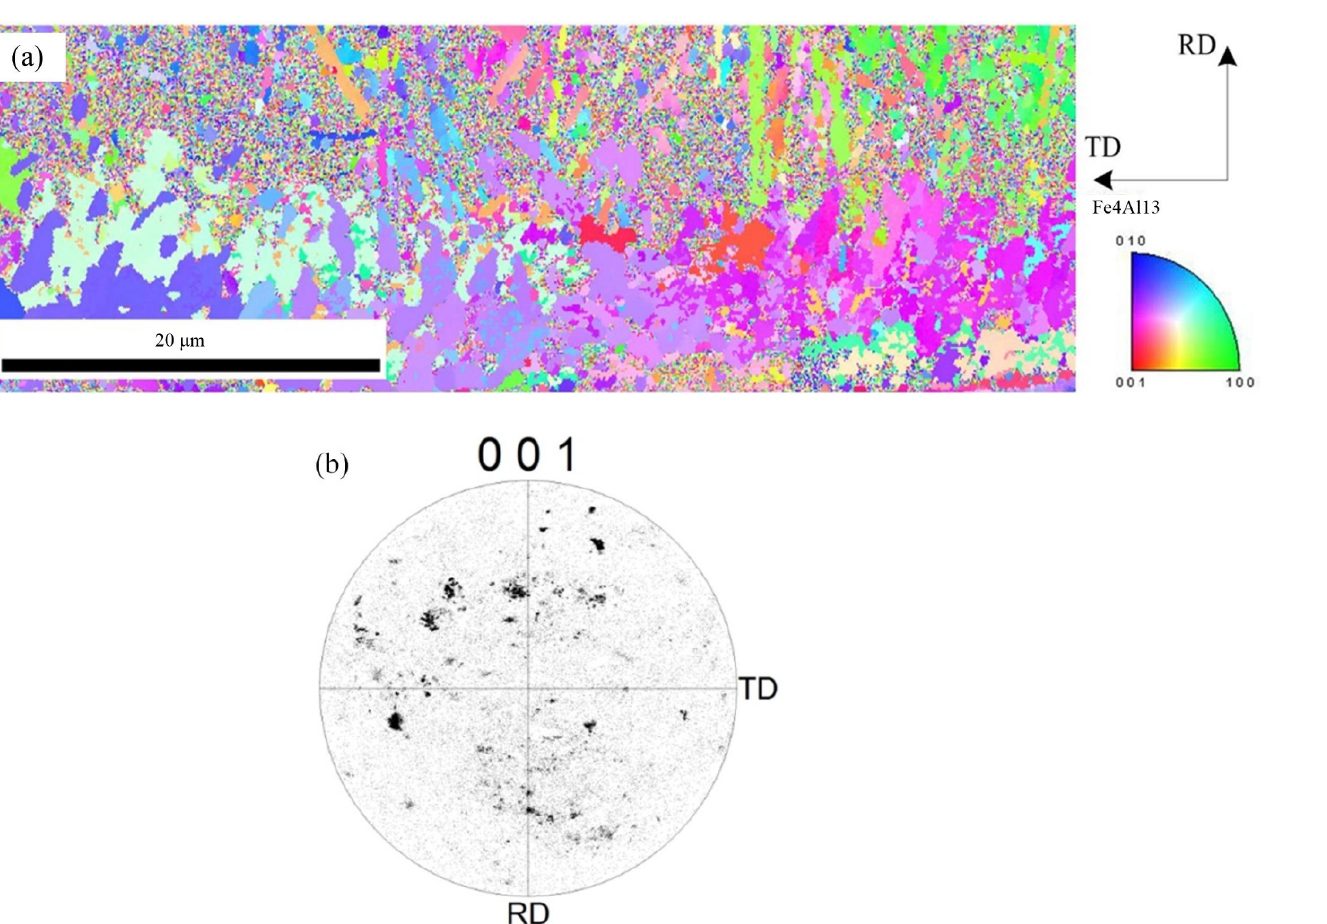
Figure 9. EBSD image of Fe 4 Al 13 phase: ( a ) inverse pole figure map and ( b ) crystal orientation.